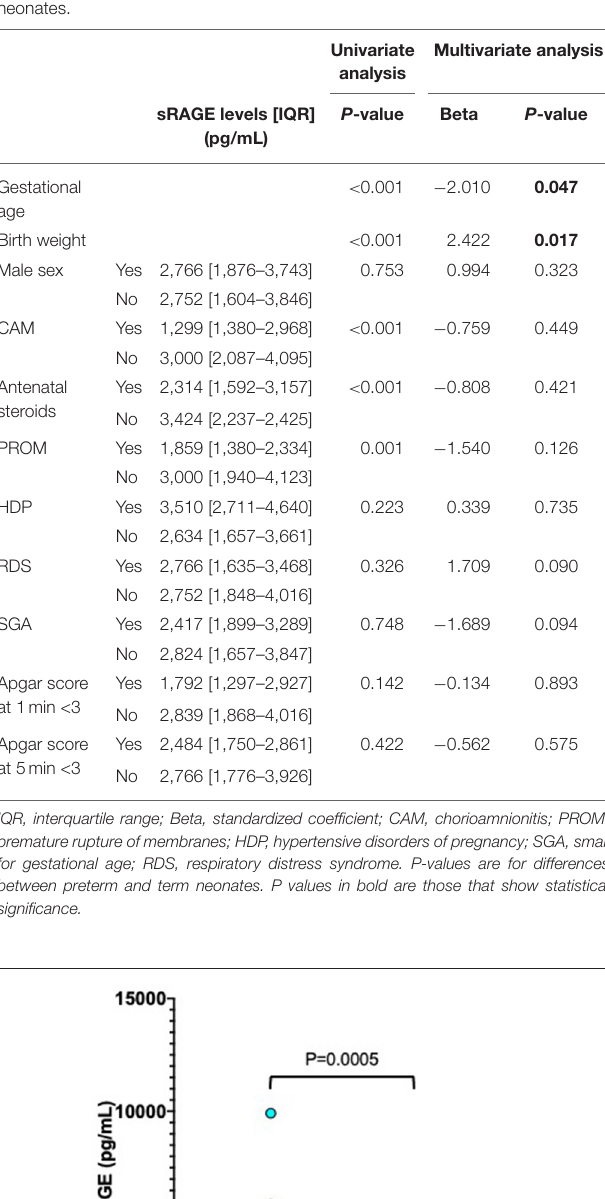
TABLE 3 | Risk factors associate with BPD by multivariate stepwise regression.